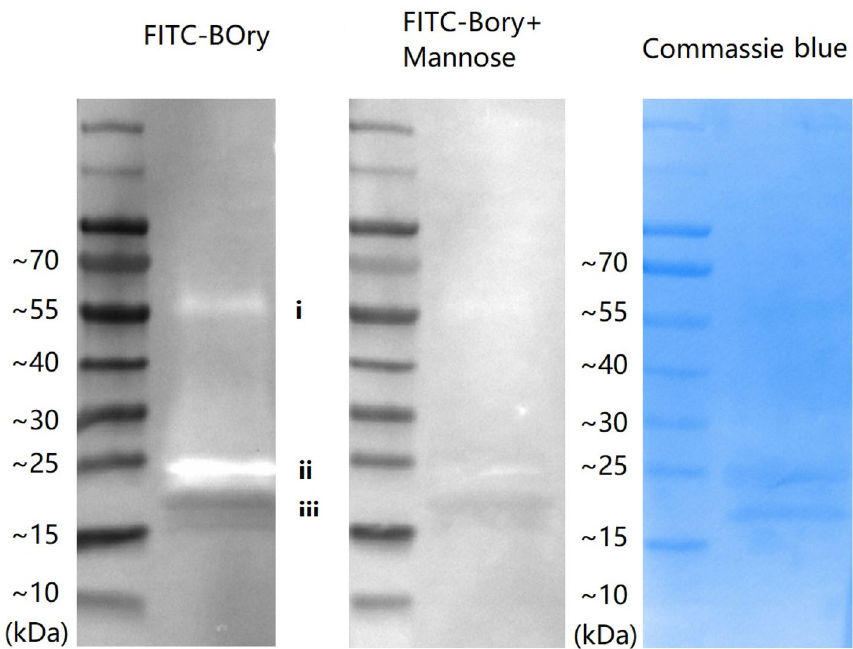
Figure 2. Glycan of YOry binding by BOry. The glycosylated (ii) and non-glycosylated (iii) form of YOry was separated by SDS-PAGE and blotted onto PVDF membrane. The blot was subsequently incubated with FITC-labeled BOry and fluorescent signals were detected using Image Lab. To confirm that BOry interaction with glycans is reversible, FITC-BOry was pre-incubated with 20 mM mannose in PBS, before being added to the YOry blot. The blot was finally stained by diluted Coomassie Blue. The band indicated with i is a possible aggregation of glycosylated YOry, and ii and iii indicate the glycosylated and non-glycosylated YOry